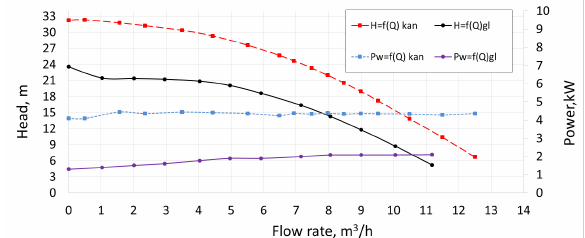
Figure 4: The flow and the power consumption curves obtained in course of the experimental tests (test rig presented in Fig. 3) of the analyzed set of discs (Fig. 2): index “kan” – grooved passive